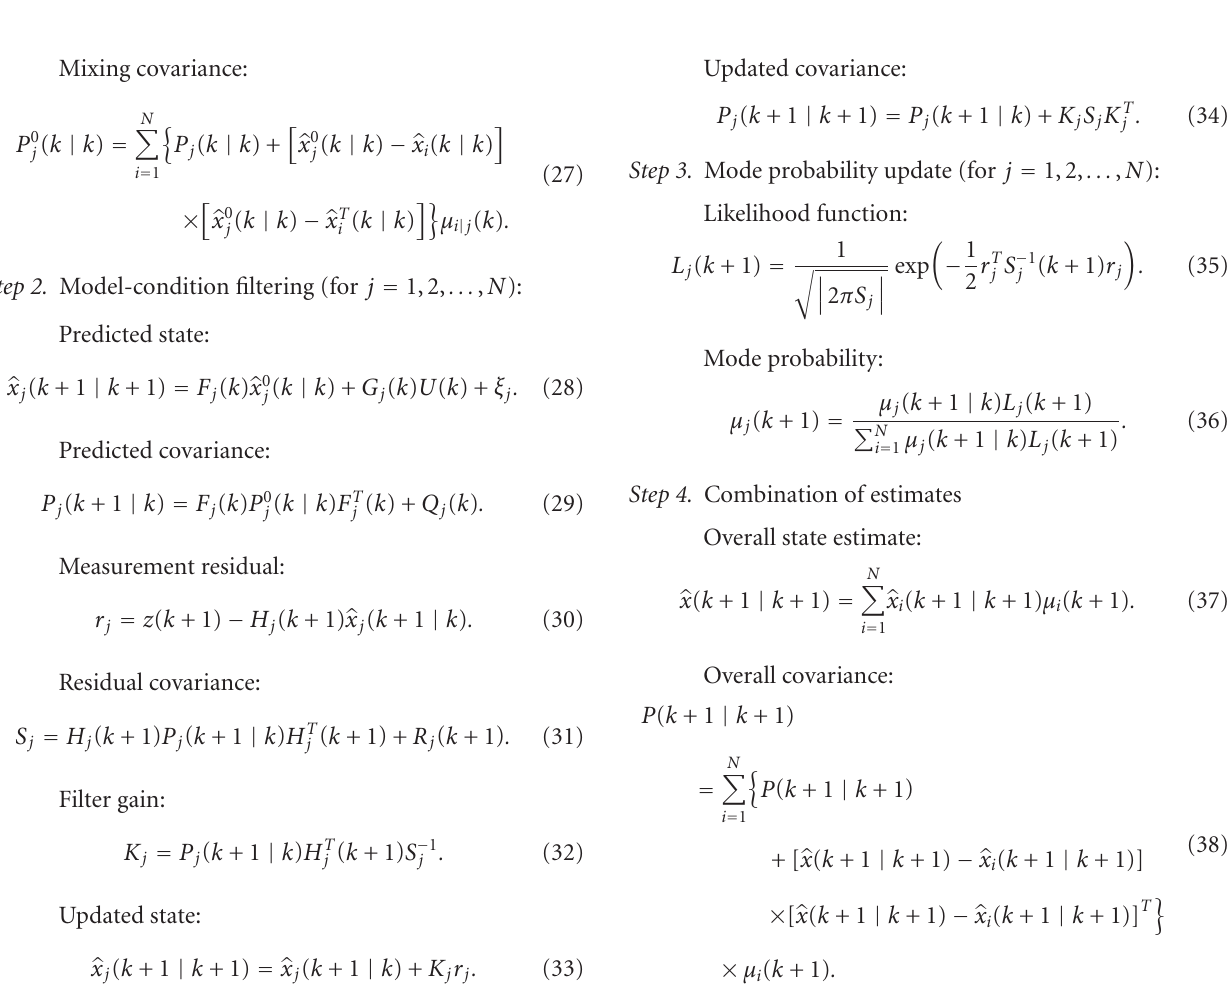
Figure 3: General structure of the IMM method